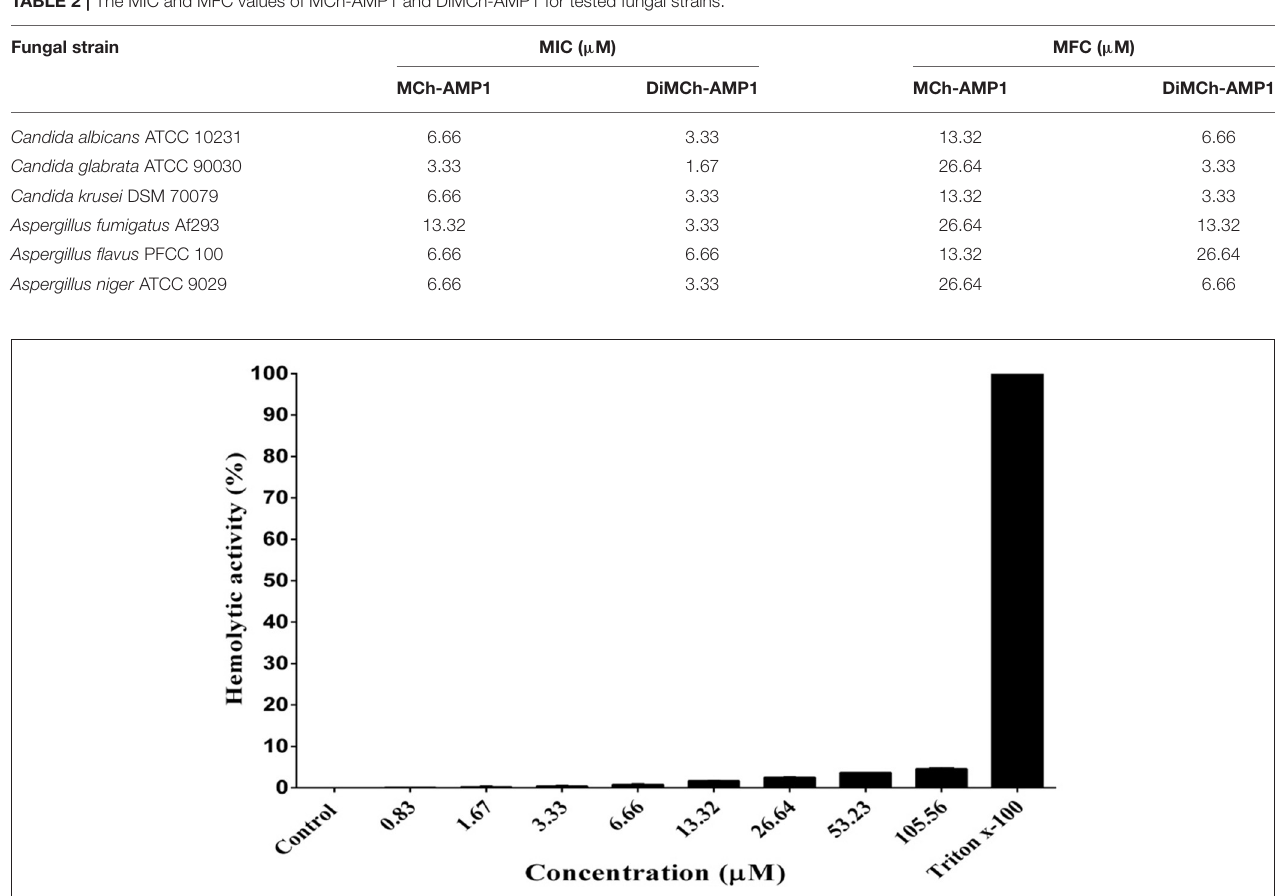
FIGURE 6 | Hemolytic activity of DiMCh-AMP1 against human erythrocytes. Results are given as the mean ± SD of three independent experiments.